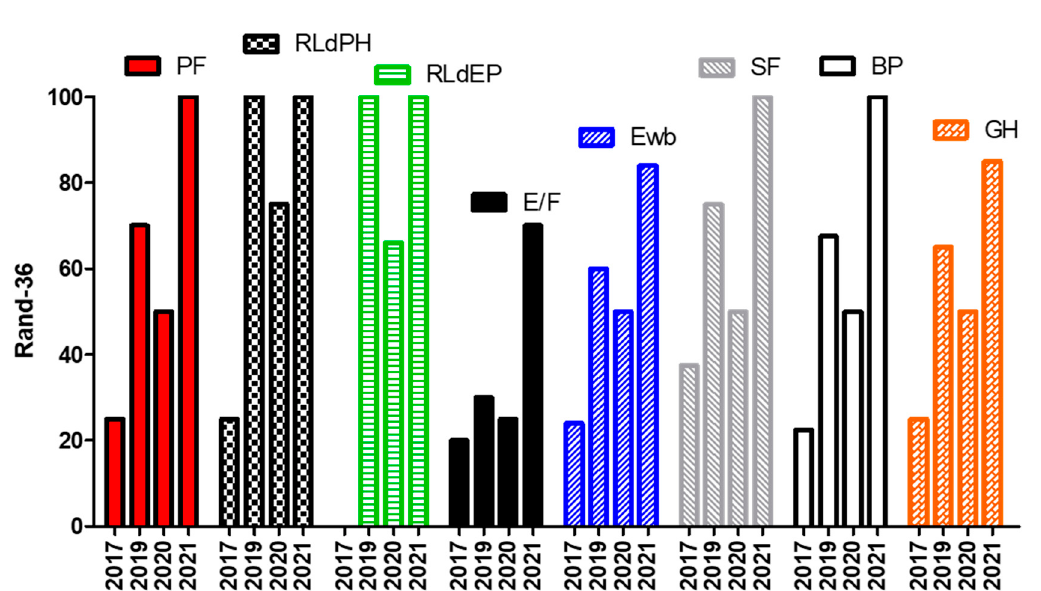
Figure 1. RAND-36 data recordings from 2017 to 2021. PF: Physical Functioning; RLdPH: Role Limitations due to Physical Problems; RLdPE: Role Limitations due to Emotional Problems; E/F: Energy/Fatigue; Ewb: Emotional well-being; SF: Social Functioning; BP: Body Pain; GH: General Health.